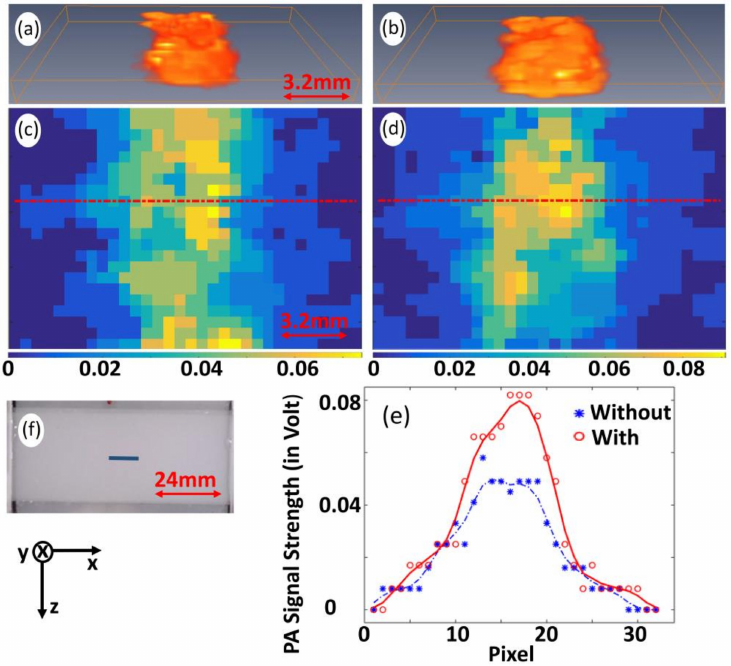
Figure 8. 3D images representative of P 0 obtained without ( a ) and with pre-illumination ( b ), while ( c , d ) give corresponding 2D images for plane (at y = 3). ( e ) Variation of P 0 and P lines indicated in ( c , d ). Photograph of tissue-mimicking Agar-sample ( f ) where marked line indicates region for raster scanning. Arrowheads in both sides of the scale bar (being included in the figure) indicate measure of entire length of the image along x